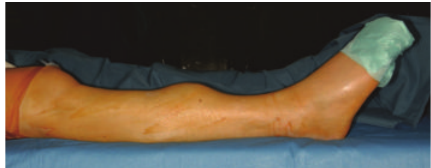
Figure 1: Preoperative clinical aspect of the right lower leg in a 23- year-old female with a multifocal adamantinoma of the tibia and the fibula.